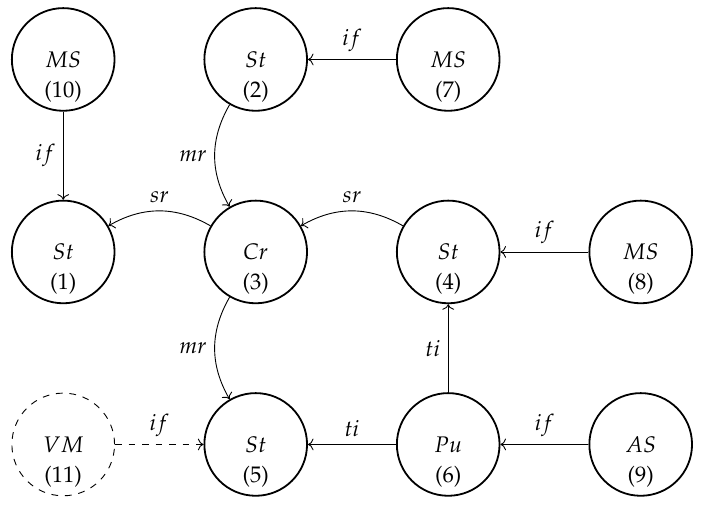
Figure 7. Graph with